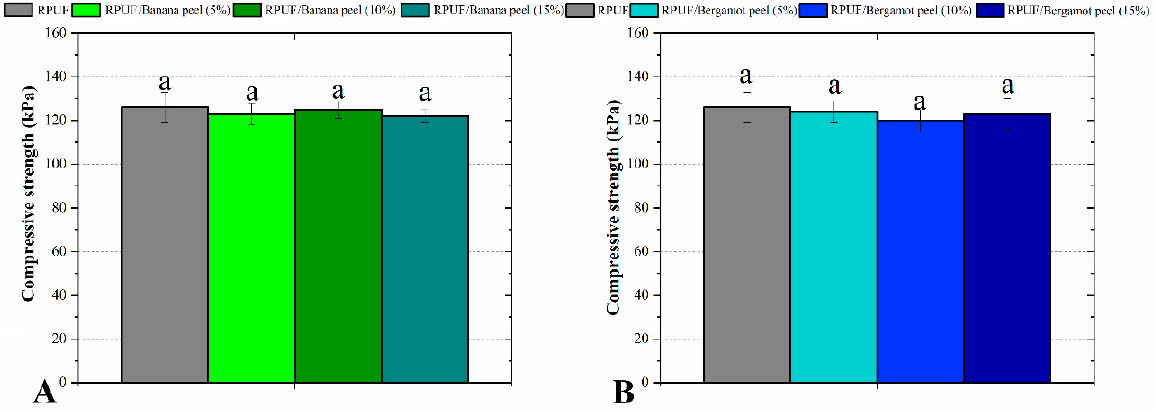
Figure 7. Compressive properties of the studied RPUF with Banana peels ( A ) and Bergamot peels ( B ). RPUF is the neat rigid polyurethane foam and filler type, and filler content is the numbers after the bars and between parentheses, respectively. Different letters represent statistically different means.